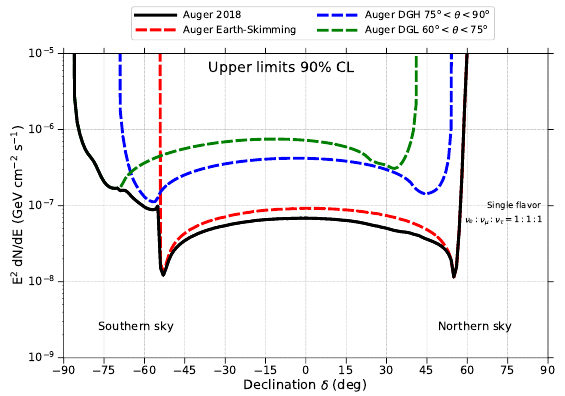
Figure 4. Pierre Auger Observatory upper limits at 90% C.L. on the normalization k PS of a single flavour point-like flux of UHE neutrinos dN / dE ν = k PS E − 2 as a function of the source ν declination δ . A ν e : ν µ : ν τ = 1 : 1 : 1 flavor ratio at Earth is assumed. Auger data up to 30 June